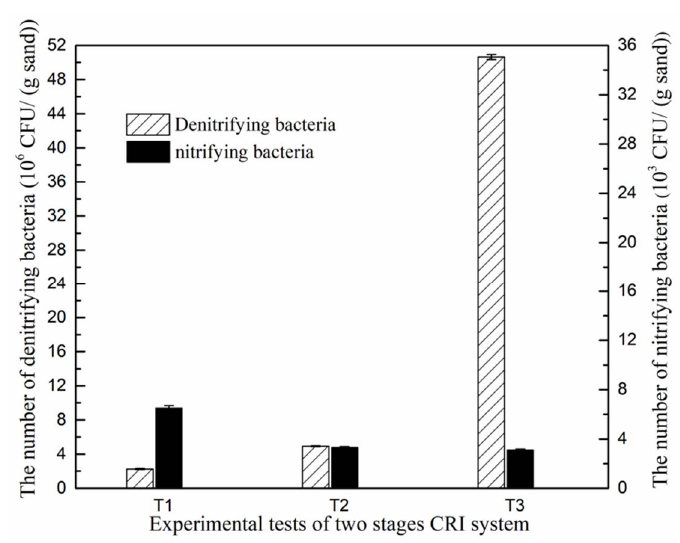
Figure 7. The number of denitrifying bacteria (10 6 CFU·(g sand) −1 ) and nitrifying bacteria (10 3 CFU·(g sand) −1 ) in the sand of the water-saturated denitrifying